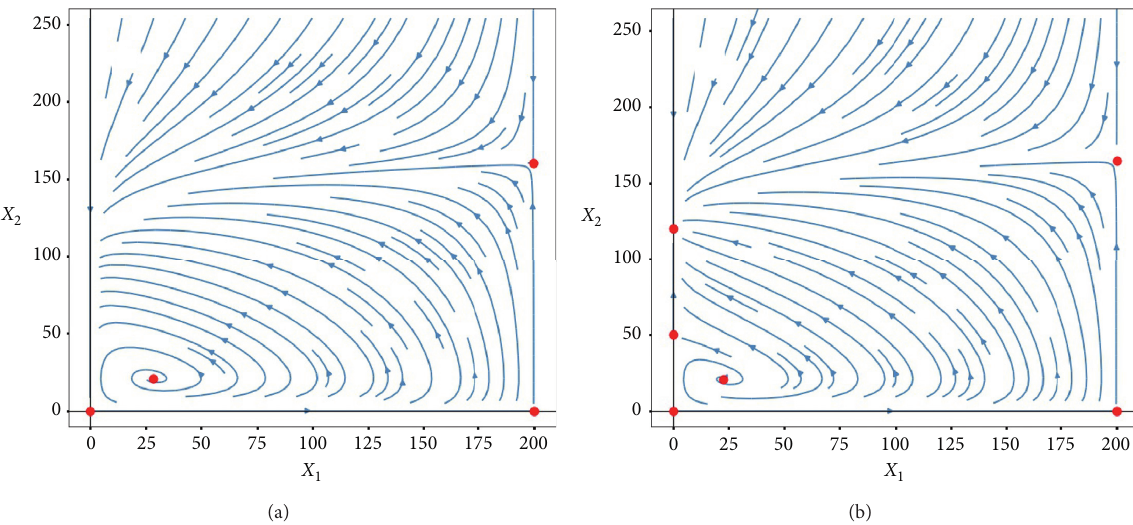
Figure 6: Phase space and trajectories for two populations involved in an antagonist interaction. To the left, we have a case with a lower � 0 . 004 than to the right, b � 0 . 005. Cooperation among predators allows two new partial extinctions of prey, one stable and one b 22 22 unstable, in the same way in Figure 1 but on the predators axis. The coexistence located at the carrying capacity of the prey remains unstable. � 0 . 15 , r � − 0 . 15 , b � 0 ,b � − 0 . 0072 , and b � 0 . 0036. Here, r 1 2 11 12 21